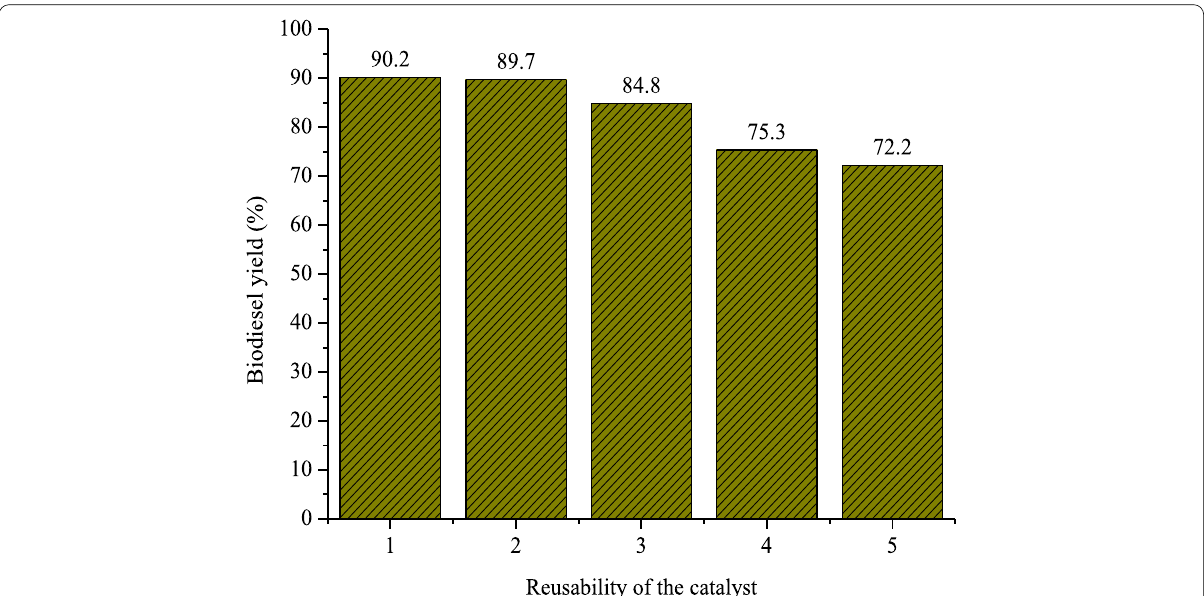
Fig. 4 Reusability of the WES derived catalyst (CaO‑based catalyst). Conditions: MTOMR 9:1; catalyst loading 5 wt%; reaction time 165 min; 65 °C; microwave power of 800